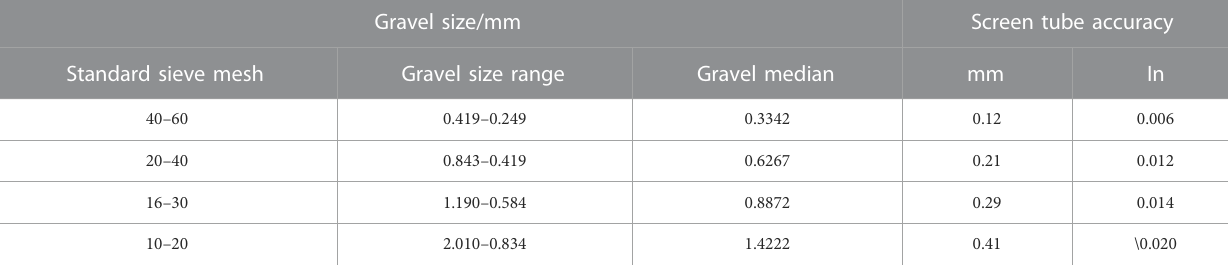
TABLE 7 Gravel size and screen tube